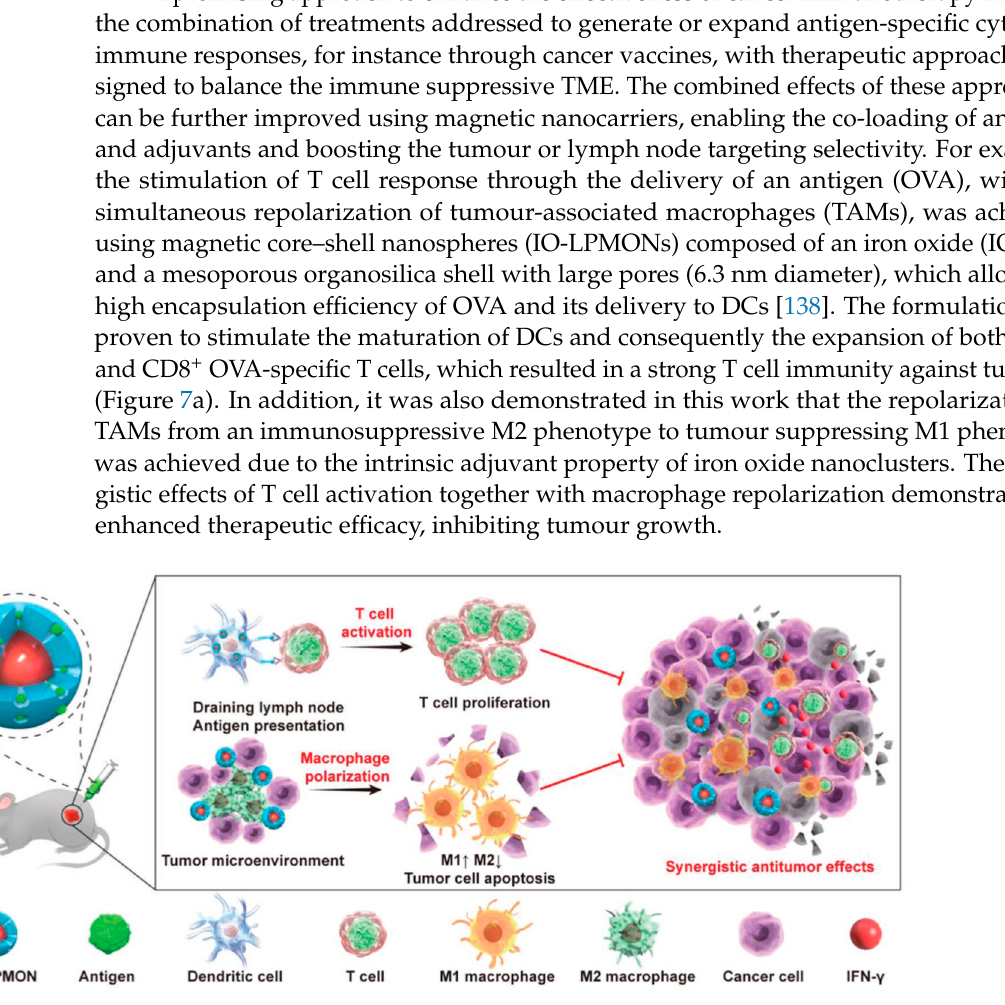
anti-PD-L1 antibodies + magnetic navigation). The arrows point the metastatic nodules in the lungs. ( c ) Quantification of the metastatic nodules confirm that MNPs can support the synergistic anti-tumour effect of checkpoint inhibitors and T cell activators, and that of the therapeutic efficacy of IO@FuDex3 by promoting specific localization of the therapeutics with magnetic navigation ( b ). Reproduced with permission from References [116,138] (Copyright 2019 Wiley-VCH